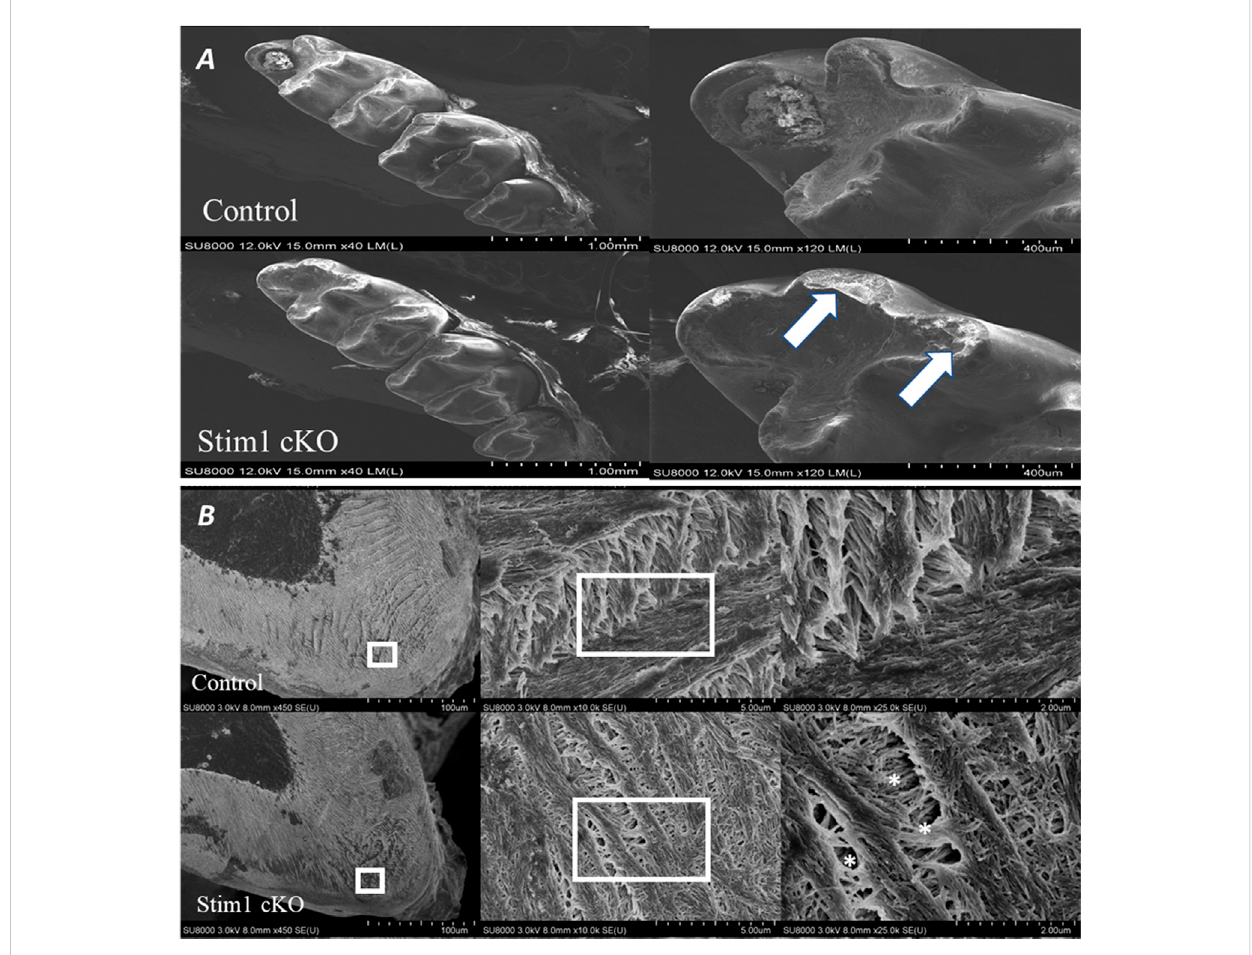
FIGURE 3 Phenotype analysis of 4-week old control and Stim1 cKO mice molars. (A) Representative scanning electron microscope (SEM) images of control and Stim1 cKO mice molars. The number and shape of cusps seem unchanged between Stim1 cKO and control mice. However, Stim1 cKO molars displayedsigni fi cantattritionontheocclusalsurfaceswhencomparedwithcontrol.Thearrowsindicatetheattritionaldefectsontheocclusalsurfacesof the cusps. (B) SEM photographs taken at a sagittal section cut through the mandibular fi rst molar. In the area of the highly resilient wavy gnarled enamel,Stim1cKOmiceshowedalesscompactcondensationofgnarledprisms.Highermagni fi cationofthegroundsectionsrevealedthatcrystallitesin thebulkenamelinStim1cKOmicewerelessimpactedandenamelrodswerethin,disorganized,andmoreporous(stars)ascomparedwithcontrolmice. The rectangular areas are enlarged in the right panel of each